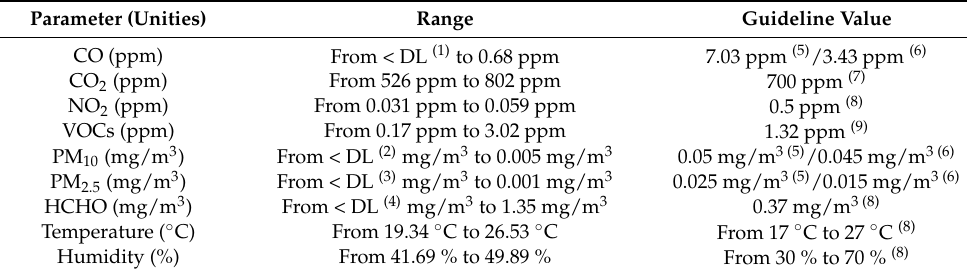
Table 2. Summary of the assessed IAQ